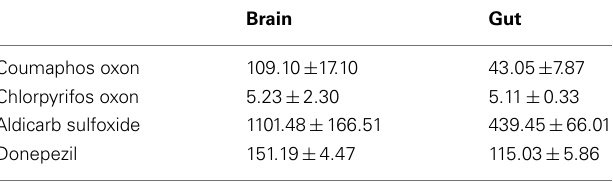
Table 3 | IC 50 values forAChE